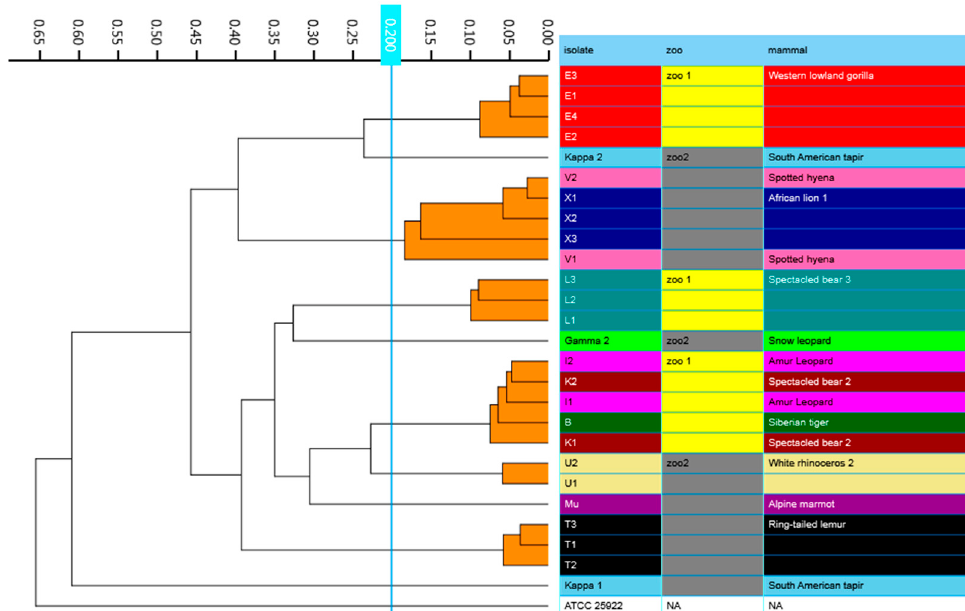
Figure 3. IR Biotyper generated dendrogram showing clustering of Escherichia spp. isolates obtained from various zoo mammals. Isolates that belong to the same cluster, using a cut-off of 0.200, are indicated with orange branches. All isolates were identified as E. coli , except for µ , which was identified as E. marmotae .